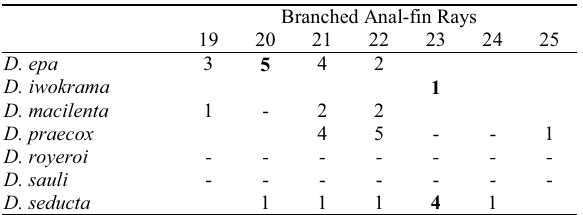
Table 17. Number of specimens of the species of Denticetopsis with cited number of branched anal-fin rays. Bold indicates value for holotype when examined. None of anal-fin rays are branched in Denticetopsis royeroi and D. sauli .